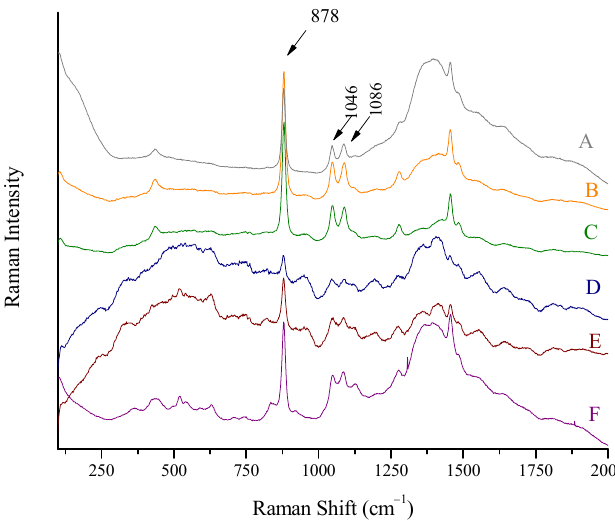
Figure 6. Raman spectra of (A) wine, Kourtaki (11.5% vol), (B) whiskey, Ballantine’s (43% vol), (C) whiskey, Jack Daniels (43% vol), (D) beer, Desperados (5.9% vol) (baselined), (E) liqueur, Fraise (baselined), and (F) liqueur, Belle Epoque, obtained using the Raman portable system and the “through the container” method. Major ethanol peaks at 878, 1046, and 1086 cm −1 are marked. Spectra of other spirits of Table 1 are quoted in the Supplementary